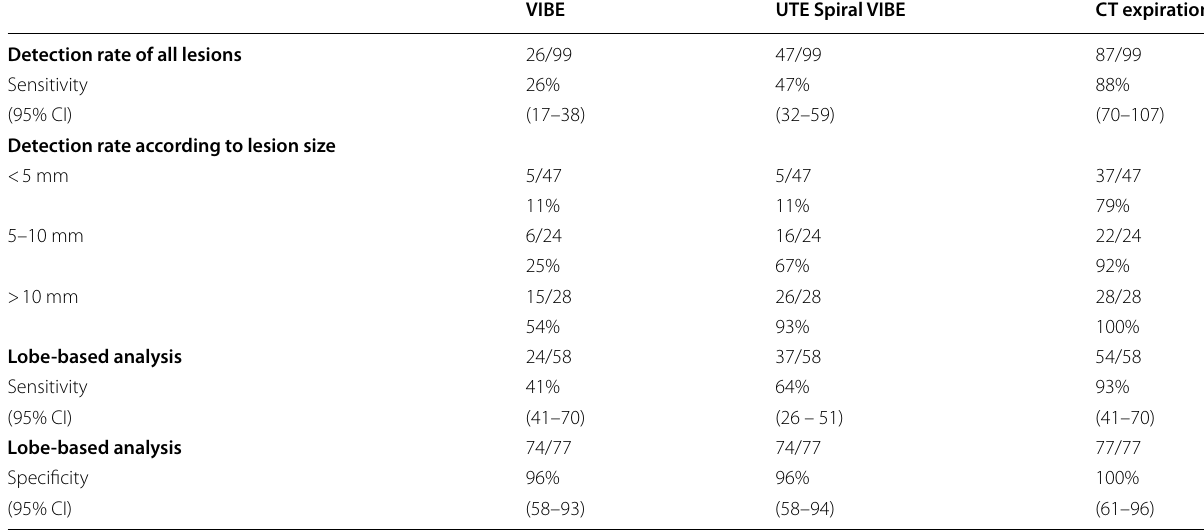
Table 2 Overview of the detected lesions according to MRI sequence VIBE and Spiral VIBE as well as CT in expiration in comparison with the gold standard of CT in inspiration both lesion‑ and